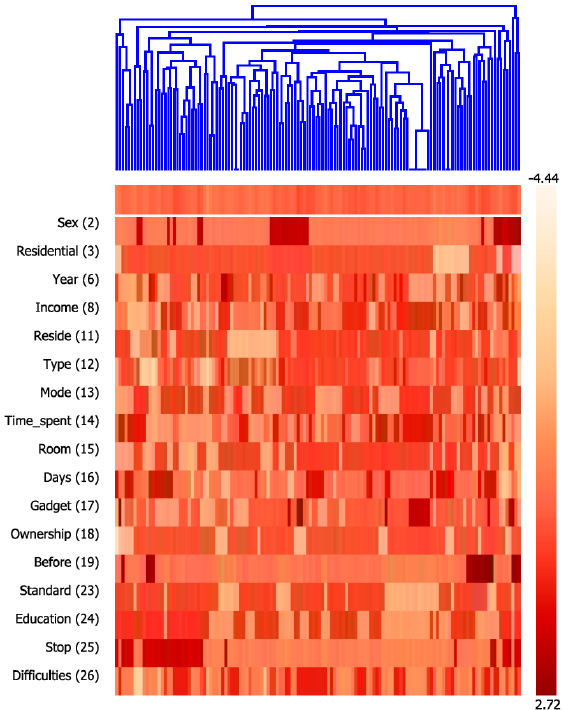
Figure 3. Hierarchical group heat map by students